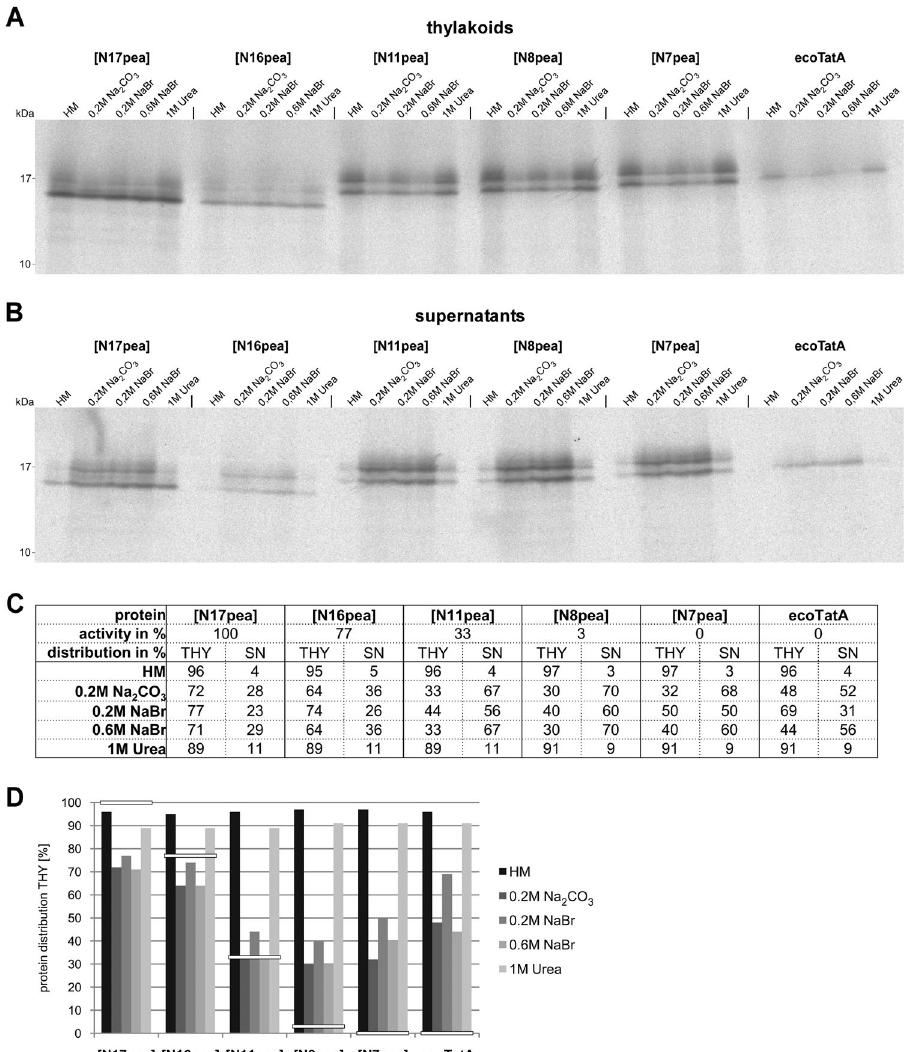
Figure 8. Integration of functional and non-functional TatA chimeras in the thylakoid membrane. E. coli TatA as well as five TatA chimeras (ecoTatA[N7pea], ecoTatA[N8pea], ecoTatA[N11pea], ecoTatA[N16pea], and ecoTatA[N17pea]) which show transport activities in the thylakoid system ranging from 0% to 100% (see Figs. 4 and 5) were obtained by in vitro translation in radiolabelled form and incubated with thylakoid vesicles under transport conditions for 15 min at 25 °C in the light. Thylakoids were washed once with HM buffer and subsequently resuspended in either (i) HM buffer , (ii) 0.2 M Na 2 CO 3 , (iii) 0.2 M NaBr , (iv) 0.6 M NaBr , or (v) 1 M Urea . After incubation for 30 min on ice thylakoids ( A ) and supernatant fractions ( B ) were collected after centrifugation and analysed by SDS-PAGE and phosphorimaging. The relative amounts of each TatA protein in the two fractions (THY and SN , respectively) were quantified ( C ). ( D ) Graph showing the relative amounts of each TatA protein in the THY fractions after membrane extraction. The activities of the different TatA proteins in thylakoid transport experiments are indicated by white bars